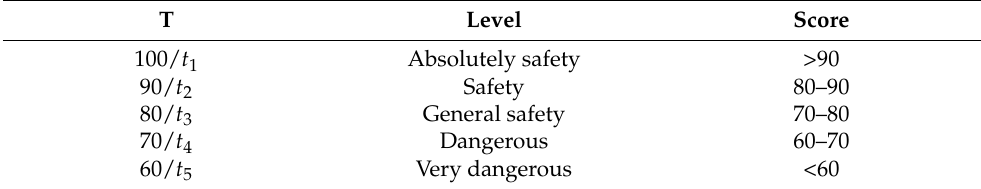
Table 2. Safety grade rating form.